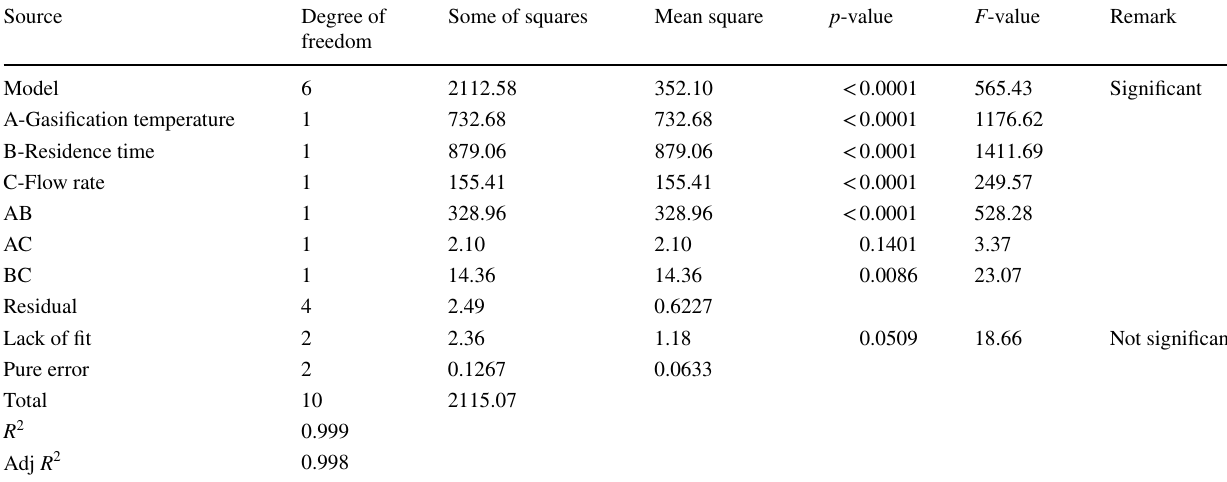
Table 9 ANNOVA analysis of LVWC II gasification